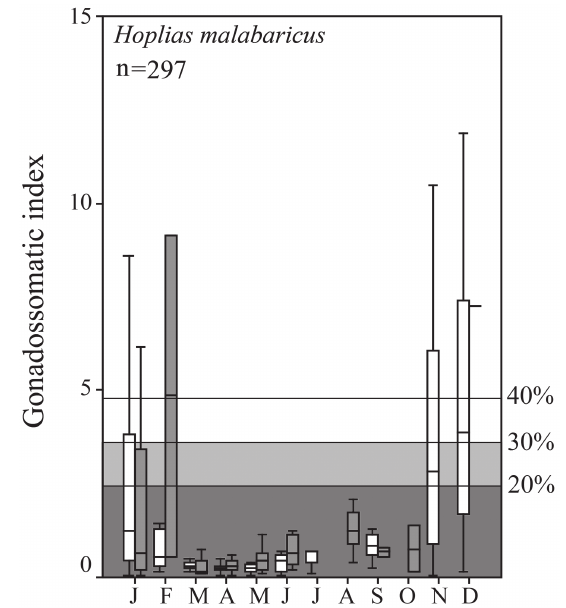
Fig. 2. Monthly variation of Astyanax fasciatus GSI values (adult females only) in Guaíba Lake (white) and Casamento Lake (dark gray), Rio Grande do Sul, Brazil (median, 25- 75% quartiles and lower-upper GSI limits by month and site). Three GSI cut-off values were tested with respect to the maximum GSI recorded for each species, for delimitation of